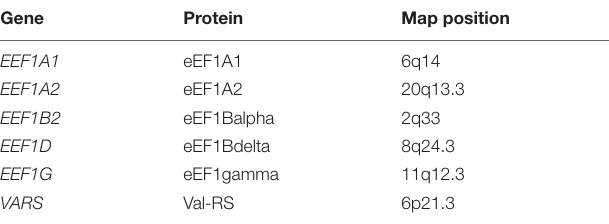
TABLE 8 | Components of the multisubunit protein complex